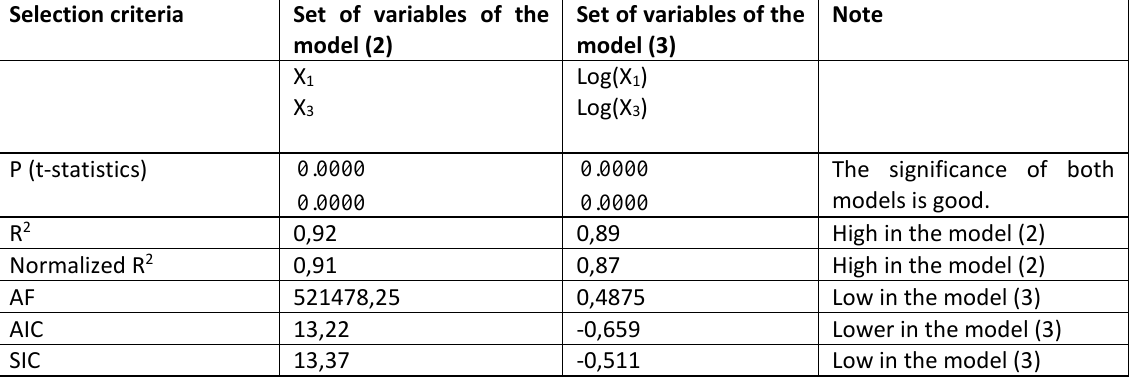
Table 8 Assessment of the quality of the regression models (2) and (3) of the total area of